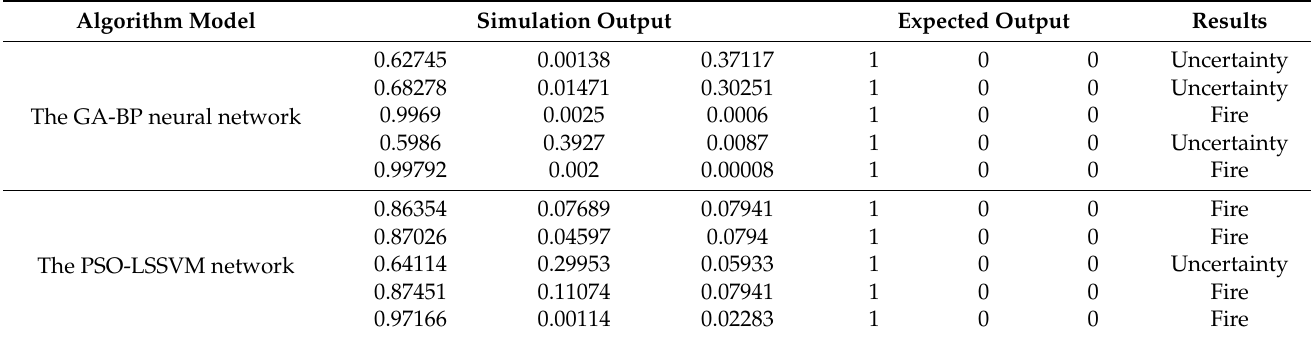
Table 6. Neural network simulation output results and expected output results.